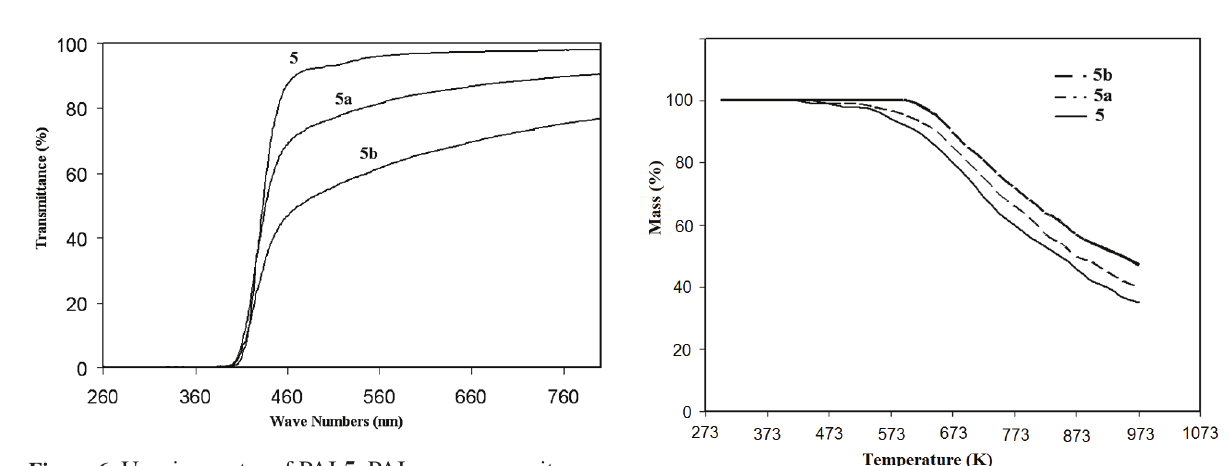
Figure 6. Uv-vis spectra of PAI 5 , PAI-nanocomposite films 5a and 5b .